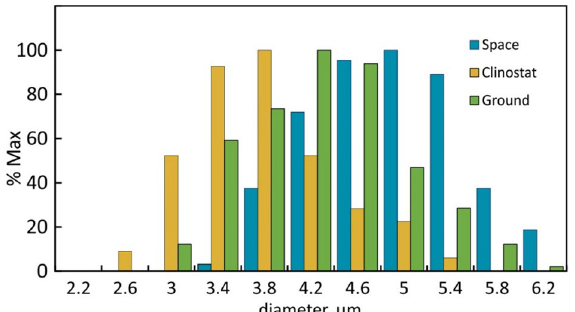
Figure 4. Size distribution of amyloplasts in the root cap of Brassica rapa seedlings grown in space, on the ground or in a clinostat. The data were compiled from 2 μm thick longitudinal sections of root cap tissue